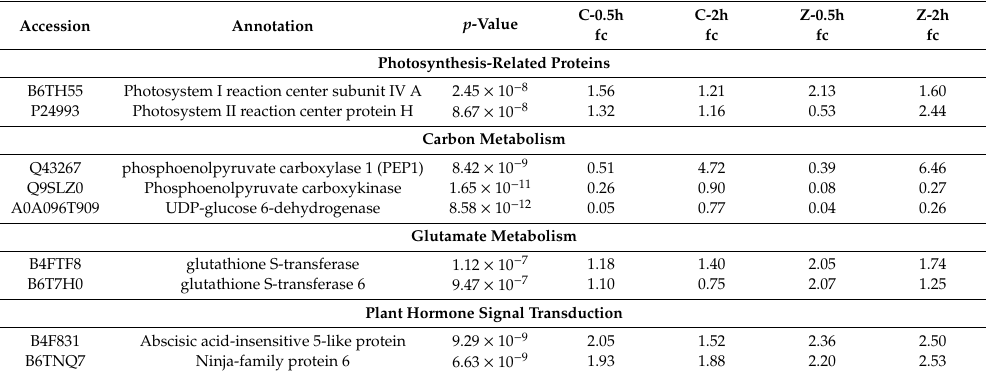
Table 2. Details of di ff erentially regulated phosphoproteins related to salt tolerance in Zheng58 shoots. Accession Annotation p -Value Photosynthesis-Related